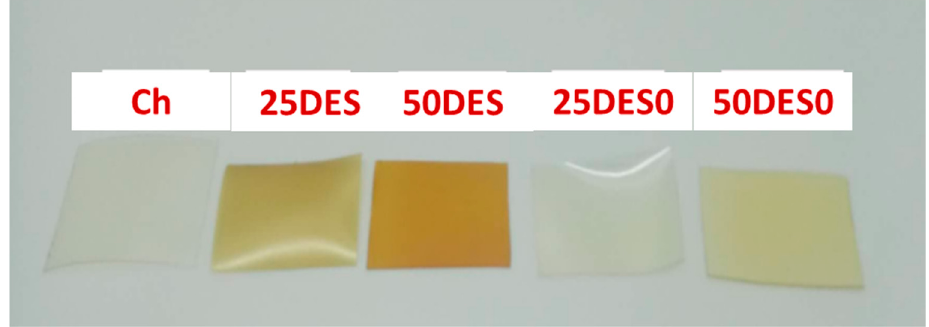
Figure 5. The color of the chitosan membranes with and without DES plasticizer and pomegranate peel extract in DES. The membranes were yellow or pale yellow in color, and clearly, those containing the pomegranate peel extract had the most intense yellow tinge. All membranes were translucent as well as relatively homogeneous and flexible, with no visible pores, insol- uble components, or cracks. Detaching them from the plastic plate was easy for all film formulations. The effect of DES and DES pomegranate peel extract on the color of chitosan membranes, as reflected in the parameters of L (brightness), a (red), and b (yellow), but also for the total color difference ( ∆ E), is presented in Table 5. Table 5. Color parameters of the various composite chitosan films (L, a, b and DE). Samples